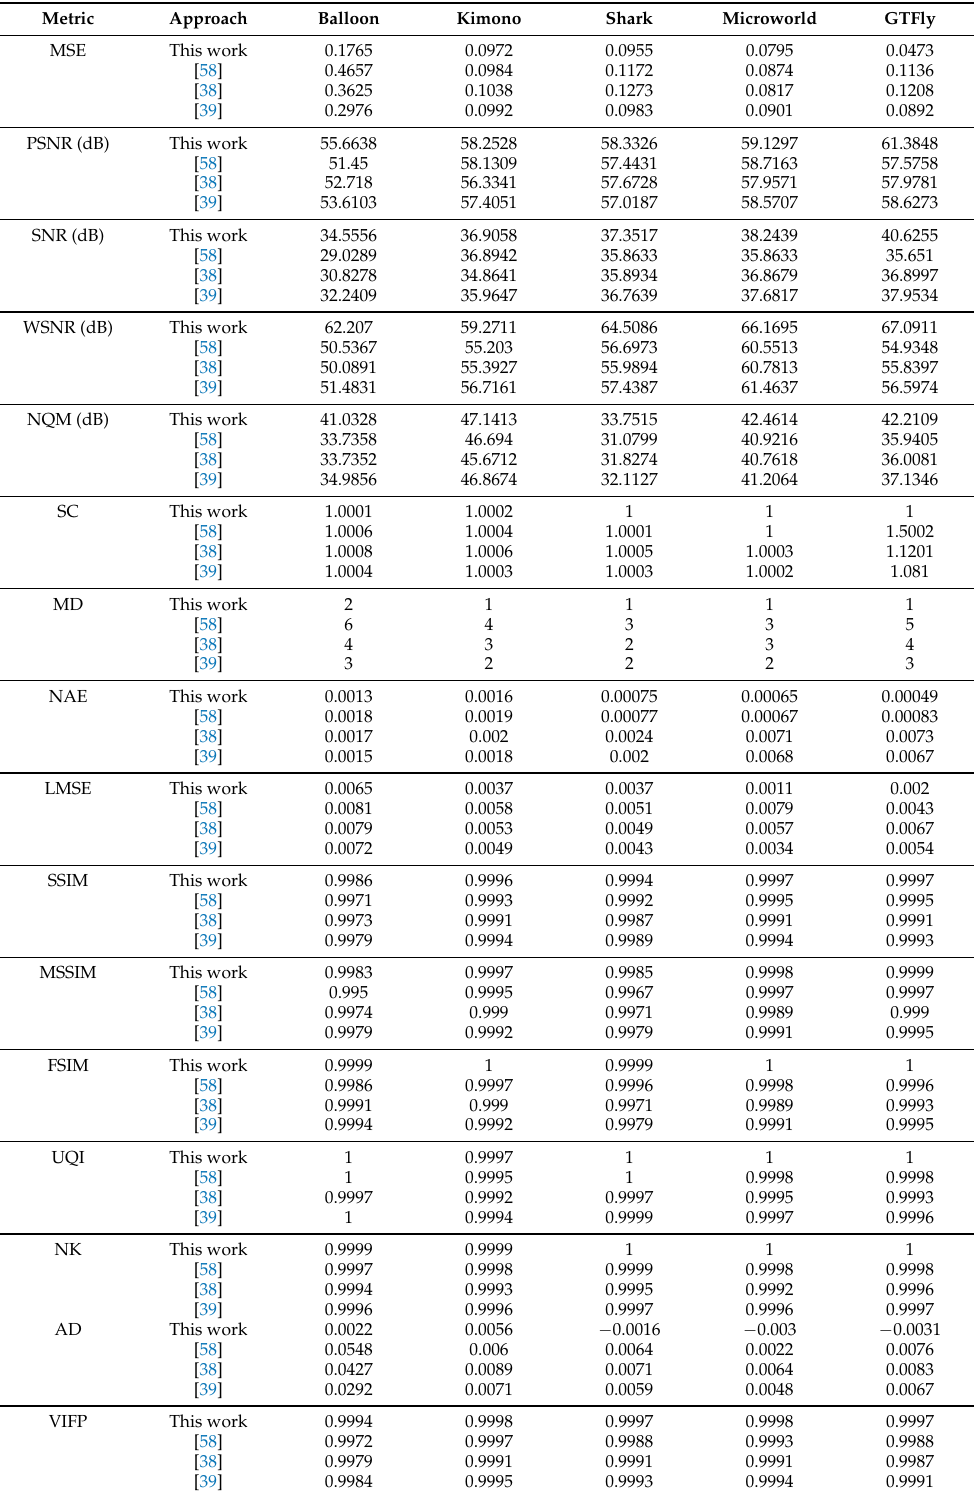
Table 7. Comparison results of objective quality assessment of tested video